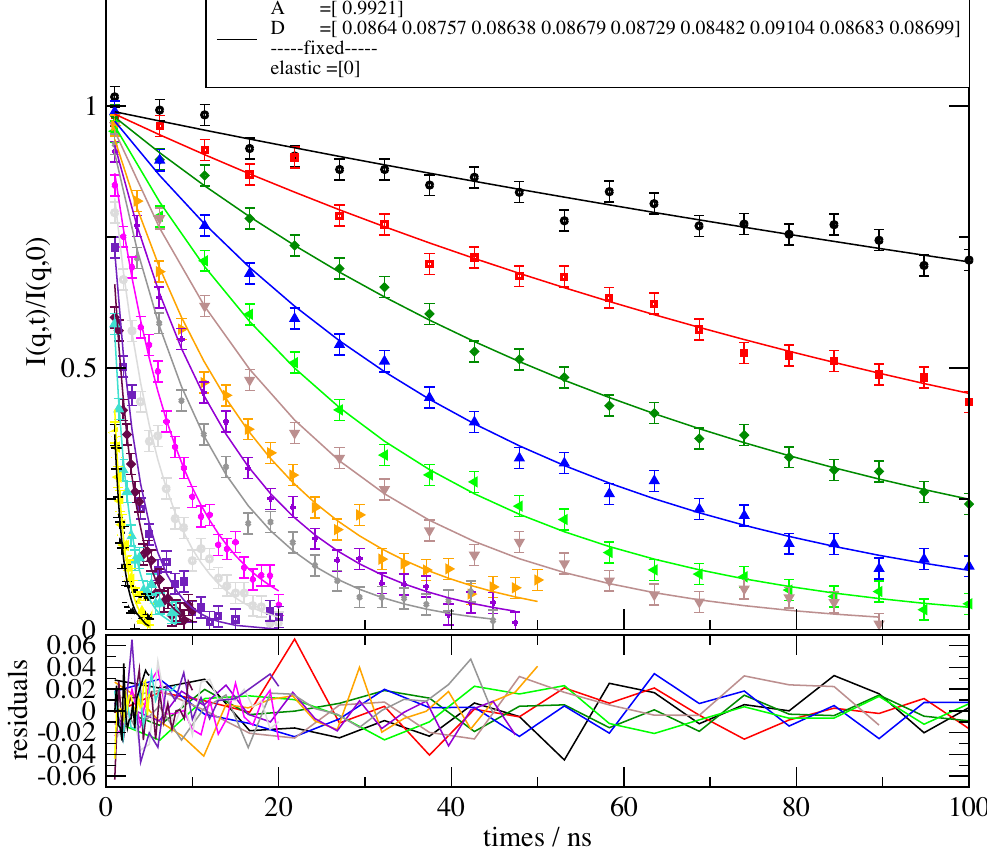
Fig 2. Residual plot showing data with the model calculation and respective residuals. The initial output has slightly changed adding correct axis titles, shortening and moving the legend and adjusting the scale using the Grace graphical user